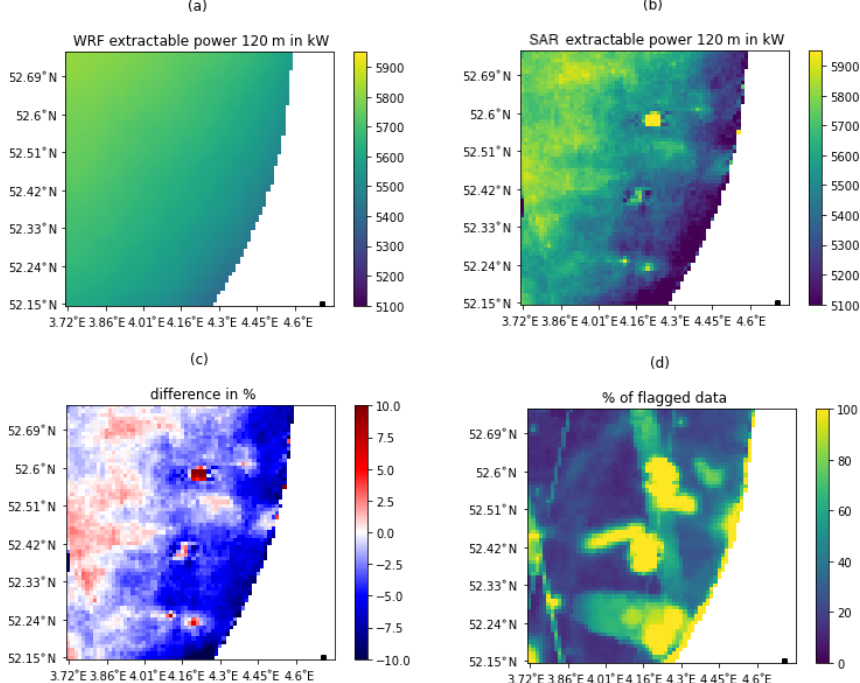
Figure 11. Wind resource at 120m over Zone 2, assuming a typical 10MW turbine: extractable wind power in kilowatts (kW) predicted by WRF (a) and SAR satellites (b) , difference in percentage (c) , and percentage of low-quality SAR data (d) .